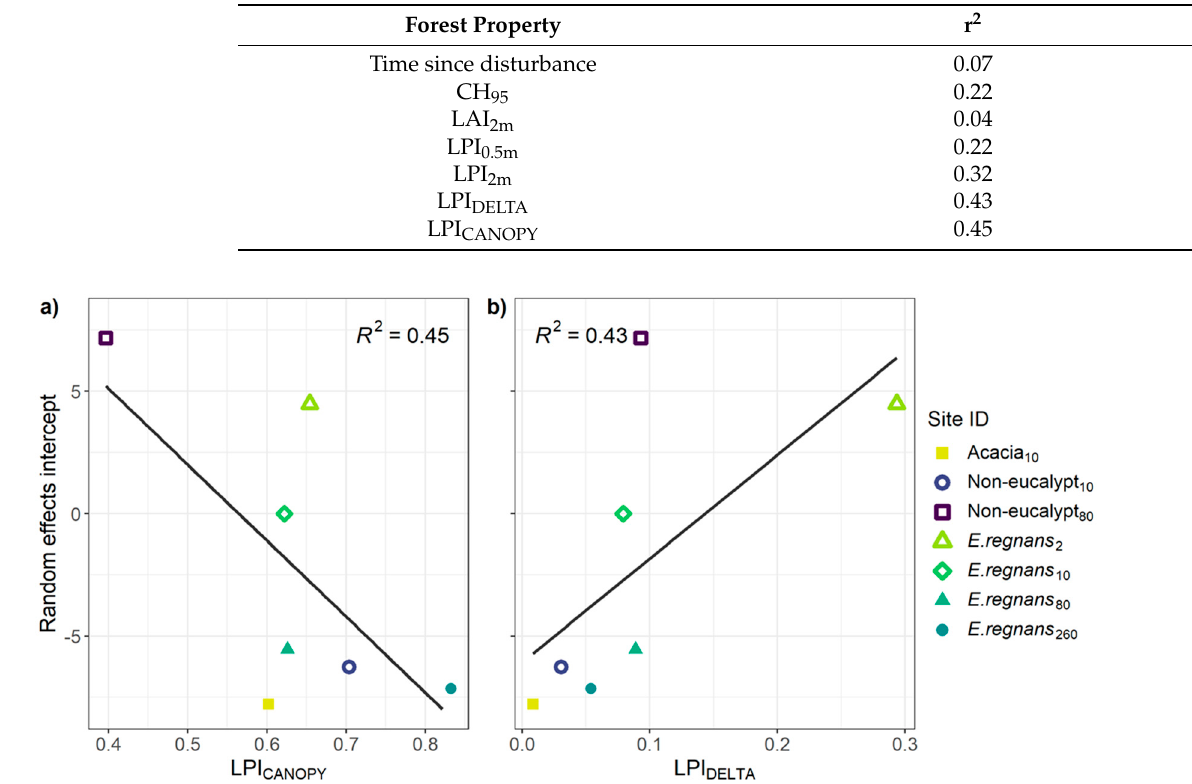
Table 6. Correlation coefficients of linear regressions between GAMM INDP random effects intercepts and forest structural properties.